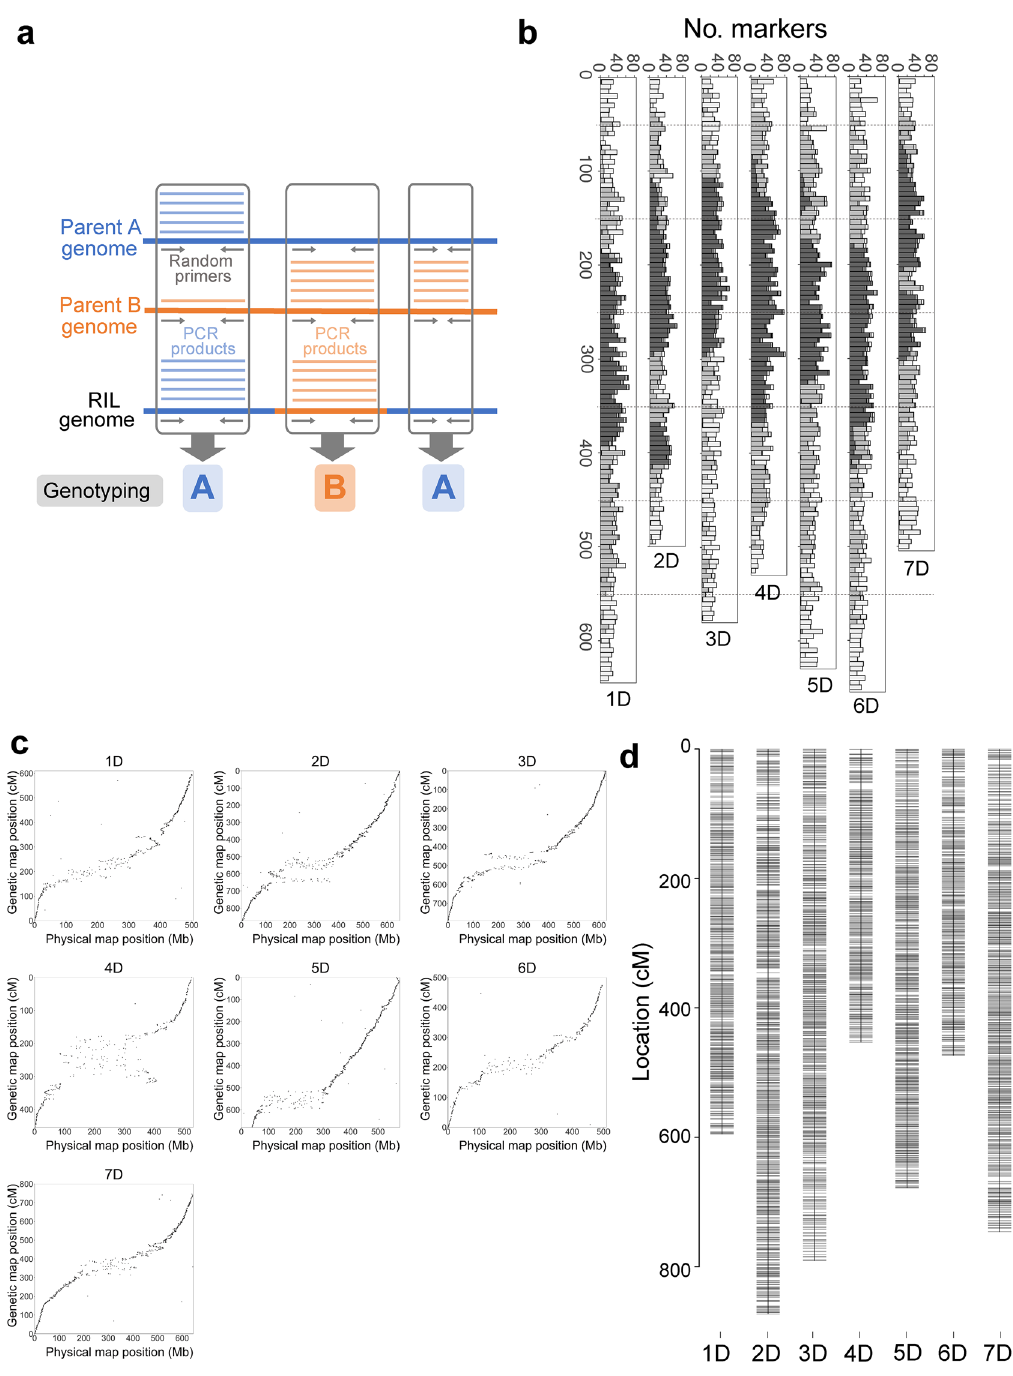
Figure 1. GRAS-Di markers in Ae. tauschii KU-2078/PI499262 RILs covered all the chromosomes and generated a genetic map with linkage groups corresponding to the seven chromosomes of Ae. tauschii . ( a ) Illustration of the genotyping method used for GRAS-Di markers. ( b ) Distribution of GRAS-Di markers on the Ae. tauschii physical map. Cumulative bar plots of the number of markers are shown every 10 Mbp. The markers were classified into three categories. The white category indicates 1–10 markers that shared the same segregating pattern of genotypes in the RILs. The grey category indicates 11 to 100 markers that shared the same segregating pattern of genotypes in the RILs. The dark grey category indicates more than 100 markers that shared the same segregating pattern of genotypes in the RILs. ( c ) Dot plots of the marker positions between the tau-D qABC genetic linkage and physical maps. The marker positions in the linkage map strongly corresponded to the physical map of Ae. tauschii . ( d ) A high-density linkage map of the RILs based on the tau-D qABC marker set. The x-axis represents the linkage group number, and the y-axis indicates genetic distance (cM). The erroneously mapped markers on the end of chromosome 5D and the large gaps were removed from the original tau-D qABC linkage map (Supplementary Fig. 3). The Cumulative bar plots and the dot plots were created with the R package ggplot2 (Wickham 2016). The linkage map was created with the R package R/qTL (Broman et al.